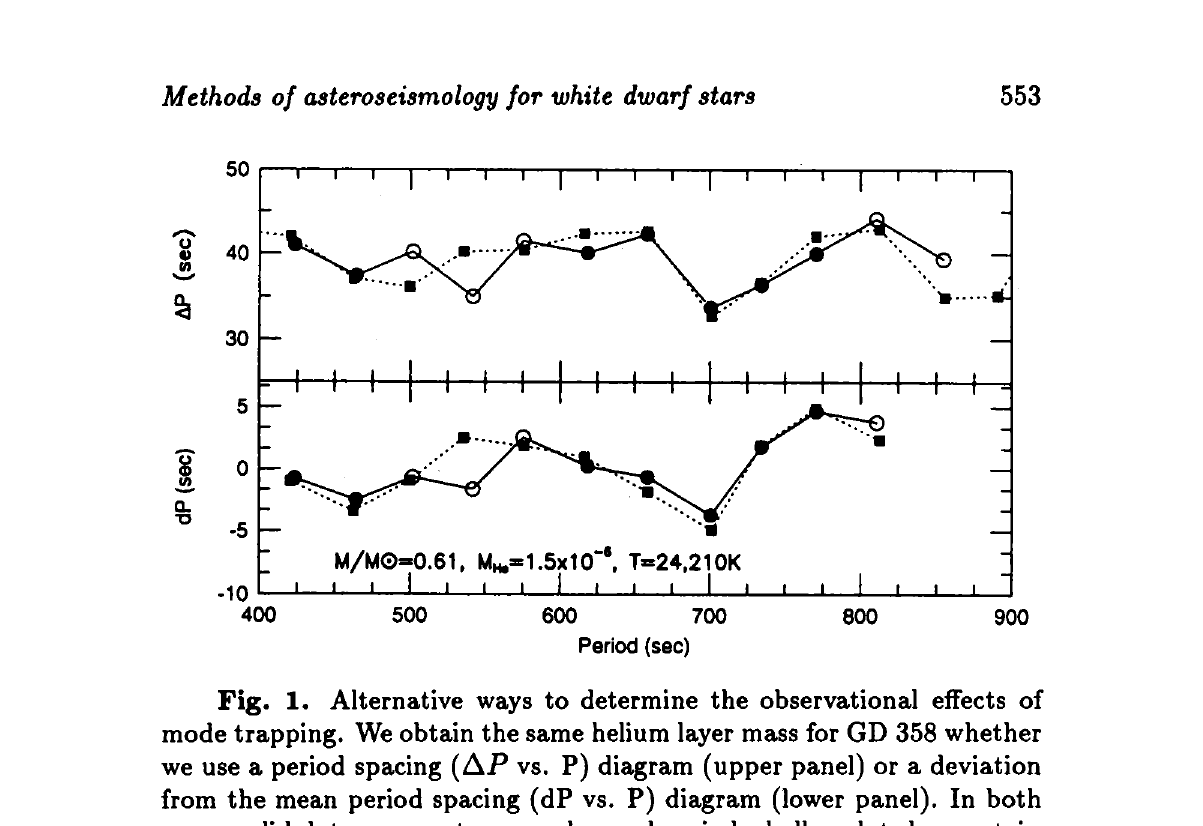
Fig. 1. Alternative ways to determine the observational effects of mode trapping. We obtain the same helium layer mass for GD 358 whether we use a period spacing ( AP vs. P) diagram (upper panel) or a deviation from the mean period spacing (dP vs. P) diagram (lower panel). In both cases, solid dots represent secure observed periods, hollow dots less certain periods and solid squares represent theoretical